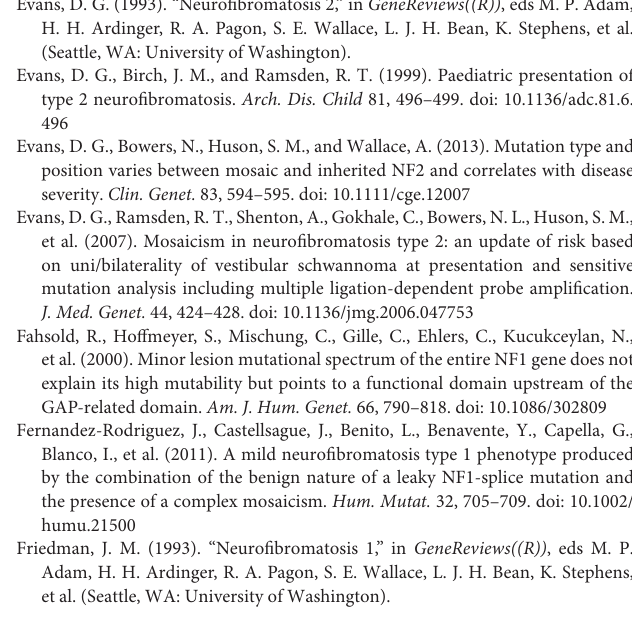
Supplementary Figure 1 | Family pedigree of the five probands with NF. “ (cid:4) ”: affected male individual. “